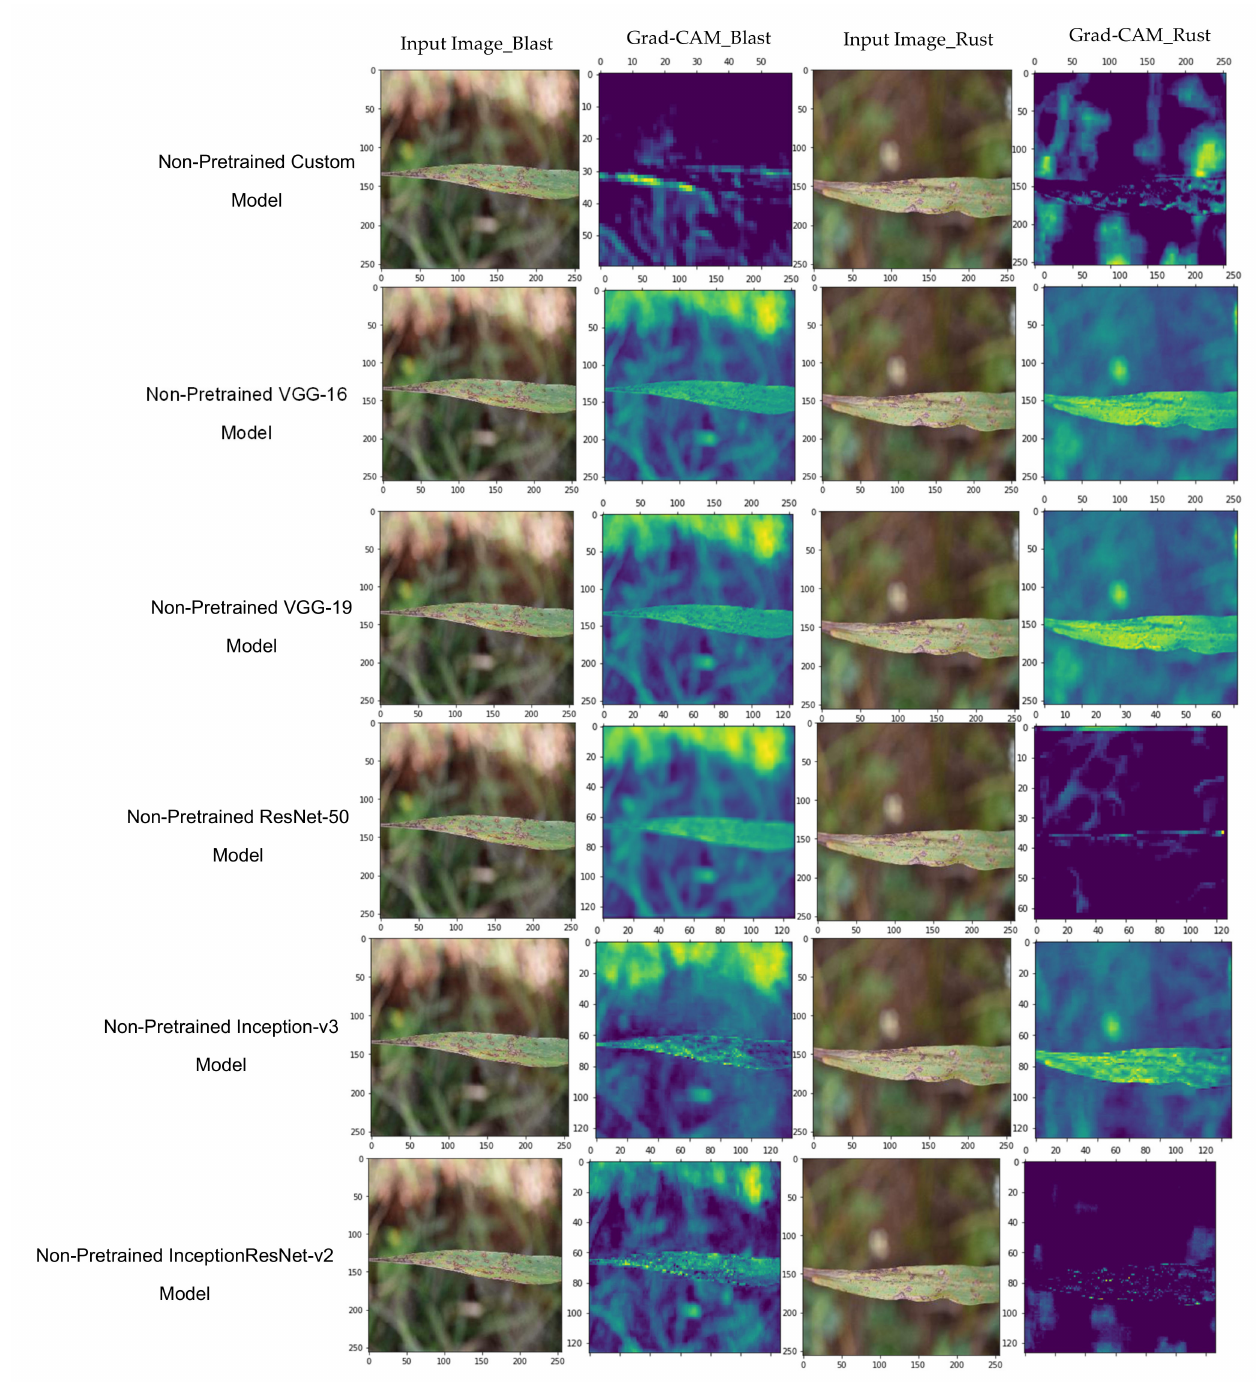
Figure 14. Grad-CAM to visualize the features of non-pre-trained